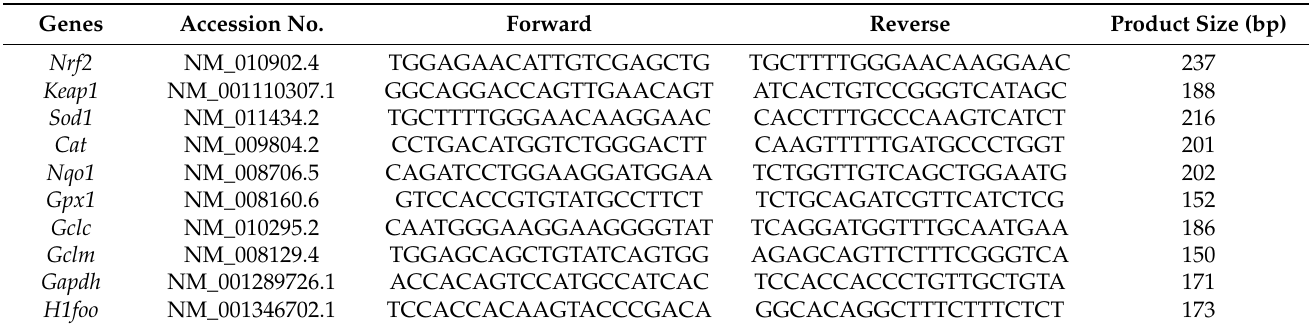
Table 1. Primers used for real-time